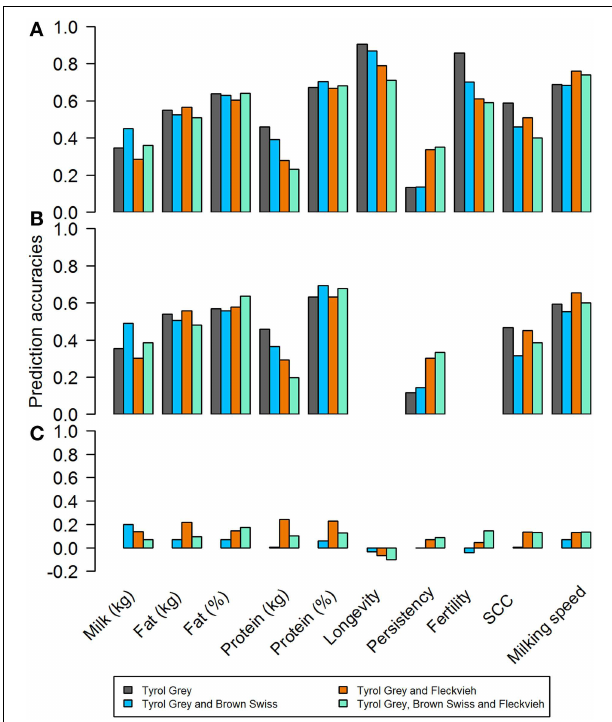
FIGURE 7 | Correlations between estimated breeding values and genomic breeding values based on (A) EBV for single and multi-breed reference sets; (B) dEBV for single and multi-breed reference sets; (C) EBV for across breed reference